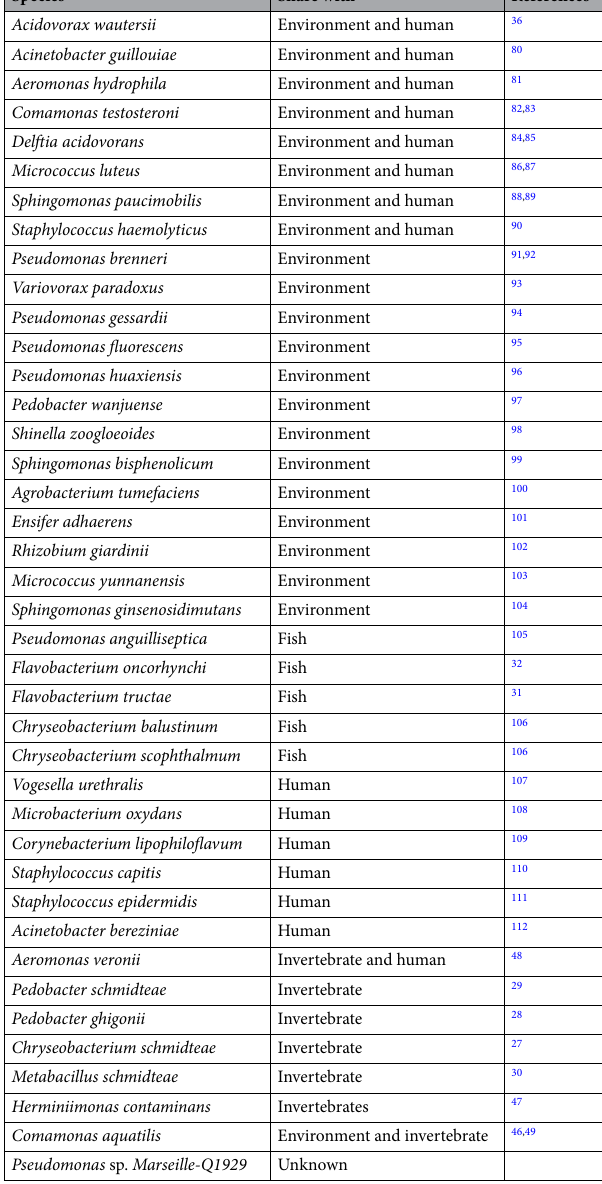
Table 3. The bacterial species identified in the laboratory strain S. mediterranea starved for 2 weeks are shared with environment, vertebrates and invertebrates. Bibliographic analysis allowed us to illustrate the potential sharing of the bacterial strains forming S. mediterranea